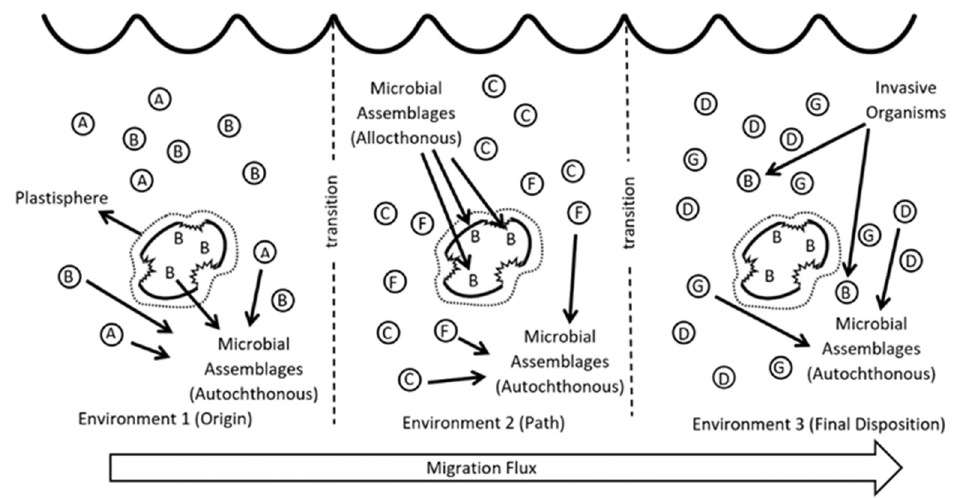
Figure 4. Transport of invasive species during microplastic migration along different sites (The varied strains of bacteria are represented by different letters: A, B, C, D, E, F and G).